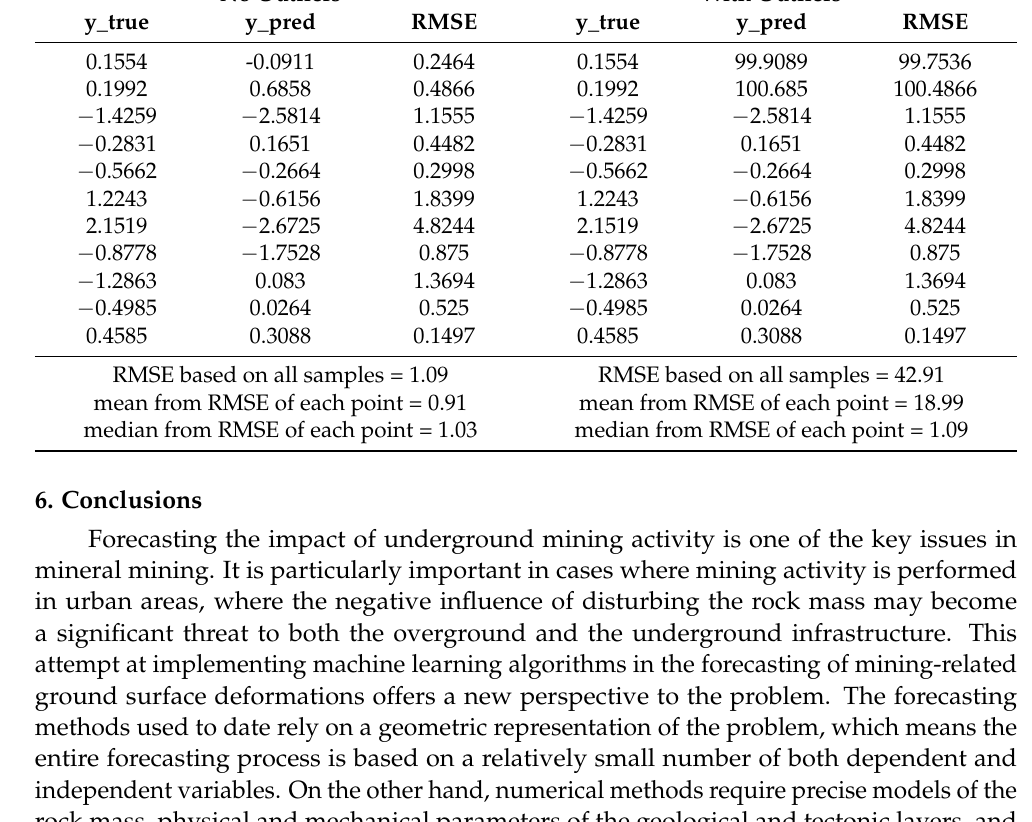
Table 5. Comparison of RMSE results for the actual and the synthetic data. No Outliers With